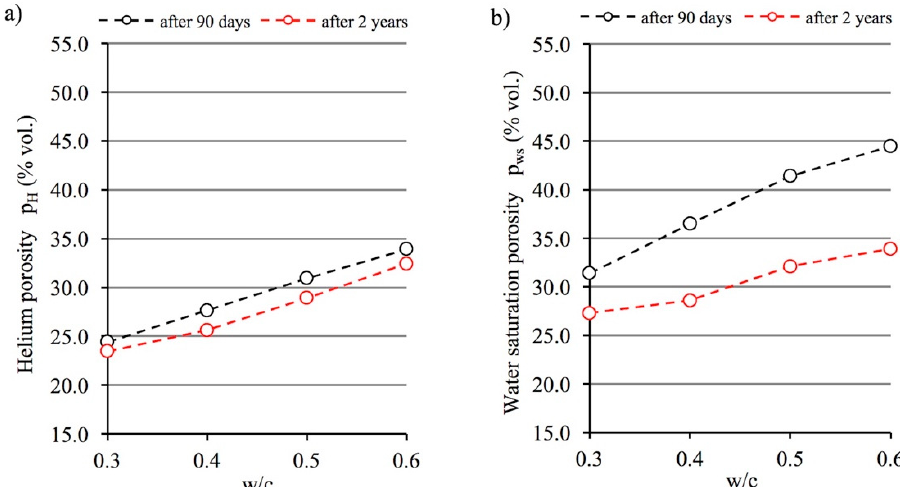
Figure 4. Relationship between helium ( a ) and water saturation ( b ) porosity versus the w/c ratio of cement pastes after 90 days and 2 years of curing.